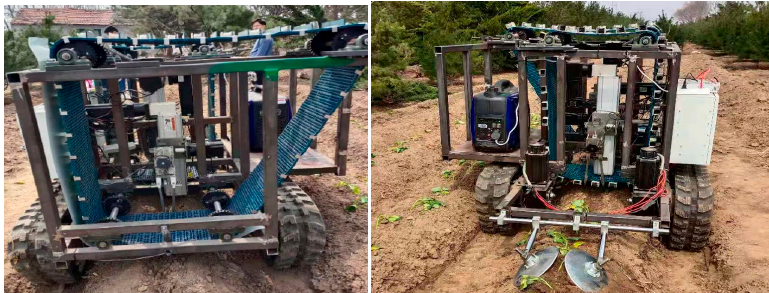
Figure 18. Experiment prototype. Table 4. Transplanting results at 0.15 m/s.